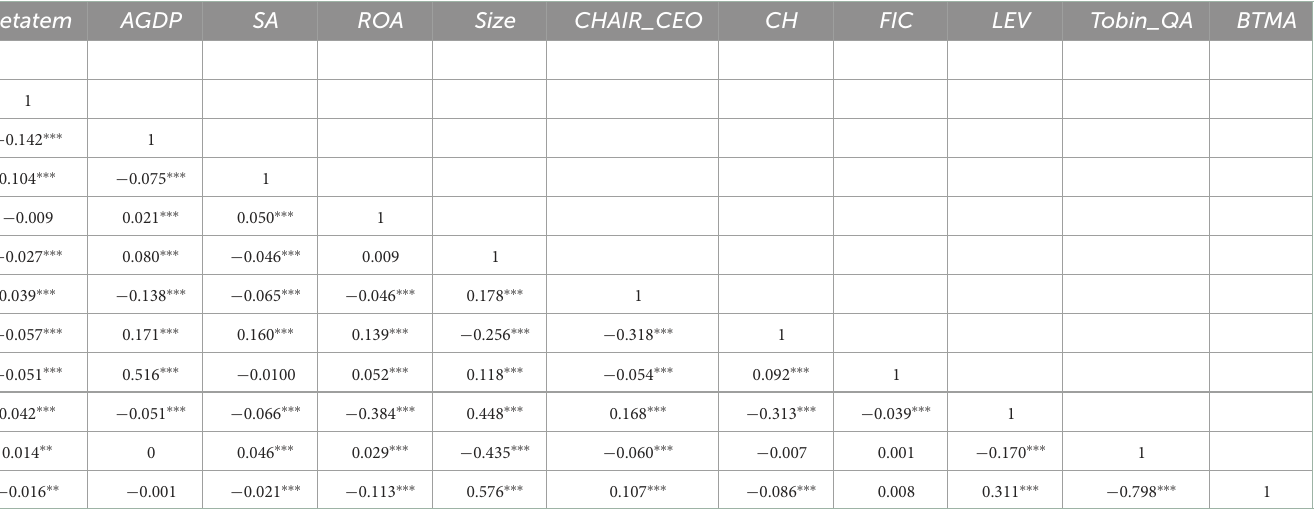
TABLE 3 Correlation